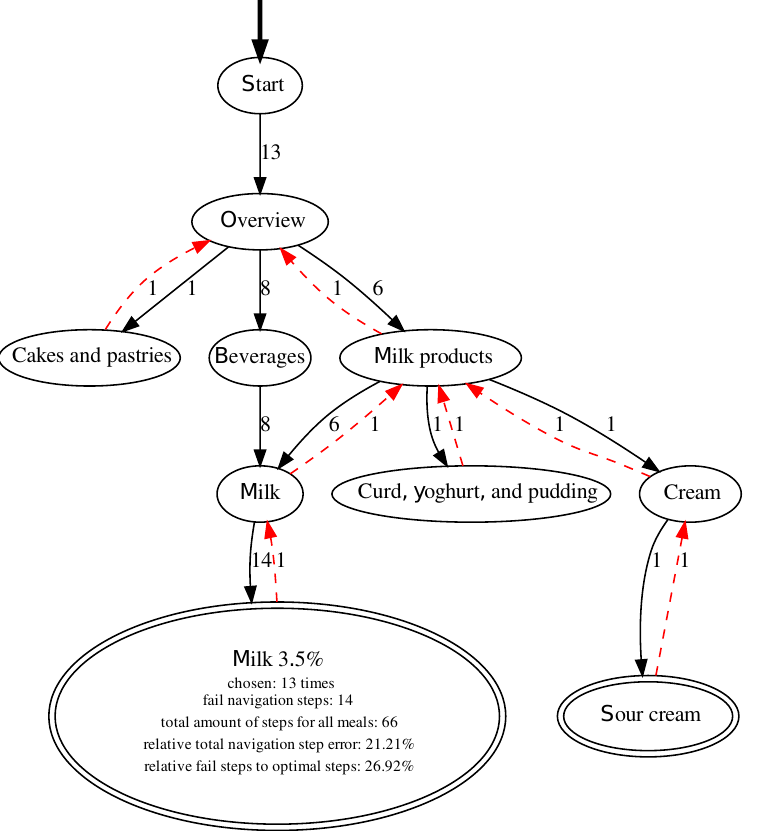
Figure 4. Example graph with all valid paths for the FoBaST item “Milk 3.5%”, including all misnavigation steps. Here there are both forward navigation steps, indicated by black arrows, and backward navigation steps, indicated by red arrows. Note: Each misnavigation step includes both a forward and a backward navigation